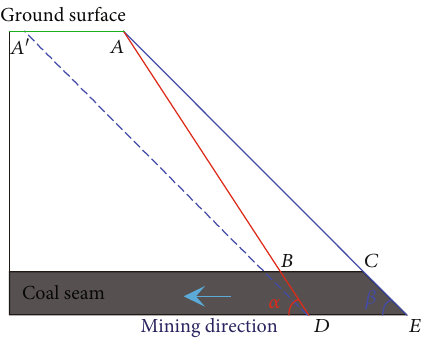
Figure 2: Mining plan with land saving and ecological detraction.